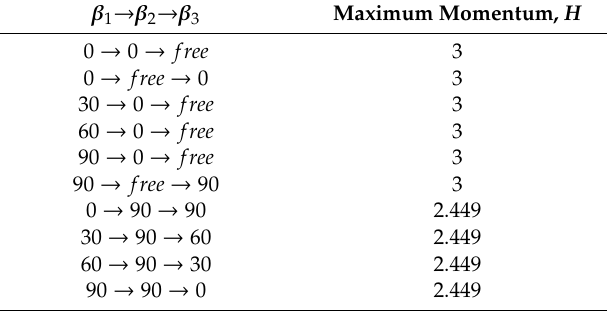
Table 7. Significant skew angles and maximum (saturation) angular